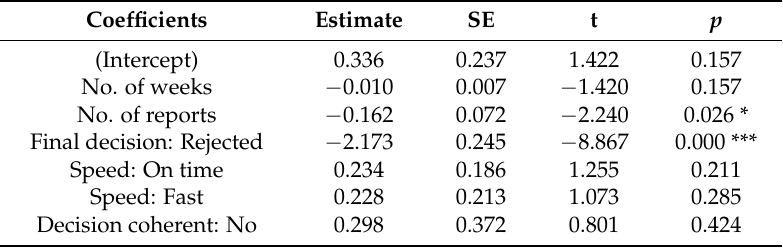
Table 5. OLS estimation of factors predicting authors’ assessments of reviewers’ competence. Reference classes were “accepted” for the final decision, “slow” for the speed of review, and “yes” for the coherence of the editorial decision.